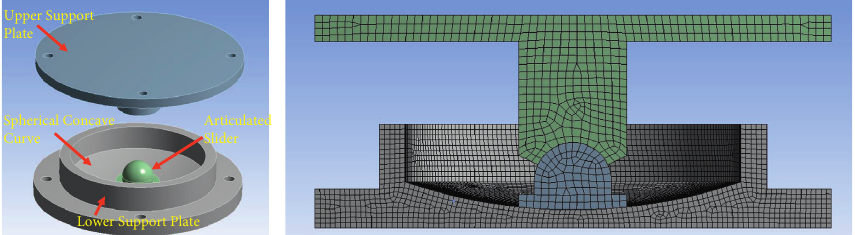
Figure 4: Finite element model of FPS.